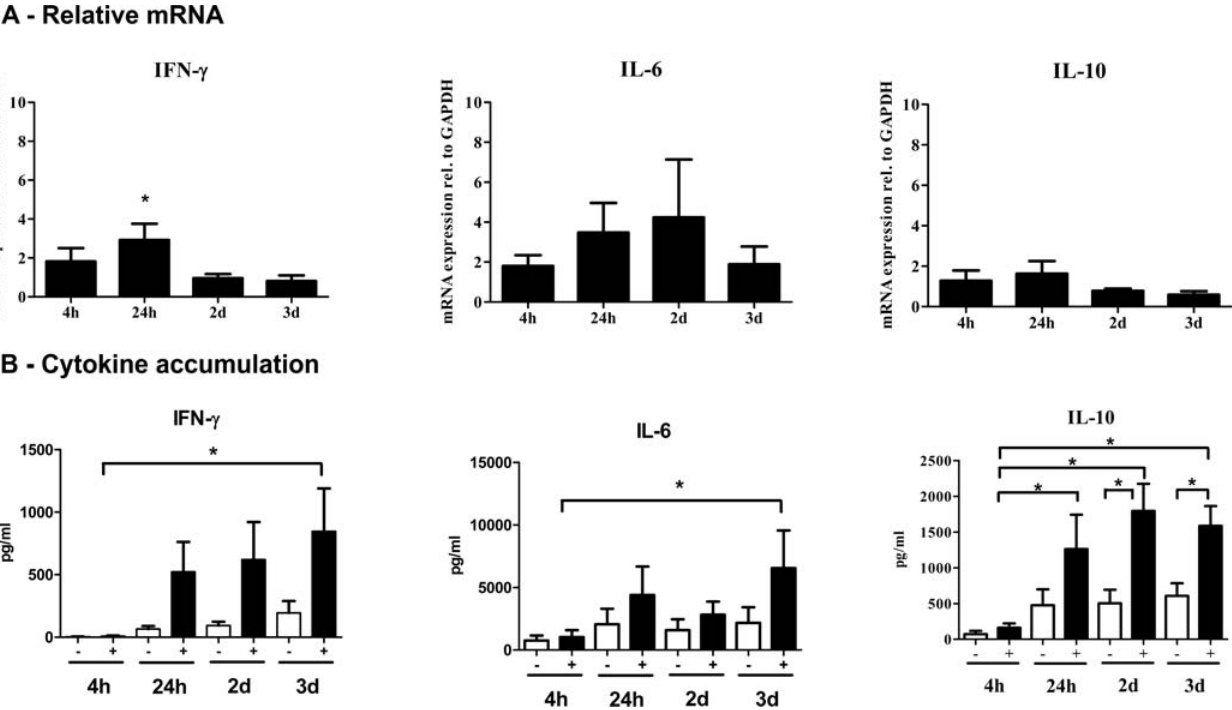
Figure 3. RT-PCR and cytokine assays of IFN- c , IL-6 and IL-10 in MDM-T-cell co-cultures. MDMs were infected with L. chagasi for 24 hours, and autologous Leishmania-naı¨ve T-cells were added for the indicated times. (A) Gene expression was examined comparing RNA harvested at the same time point from infected versus uninfected co-cultures. All mRNA levels were normalized to GAPDH. (B) Supernatants were collected after the indicated times of co-culture from uninfected ( 2 ) versus infected ( + ) MDM-T cell co-cultures. Cytokine concentrations were measured using Lincoplex (Millipore) cytokine beads. Standard curves were generated using standards provided by the company. Data for relative mRNA levels or cytokine concentrations represent the mean 6 SEM of three independent infection experiments from different human donors. *=p , 0.05. Statistical analysis was performed using (A) 1-way ANOVA and Tukey’s Multiple Comparison Test or a (B) 2-way ANOVA test, respectively.